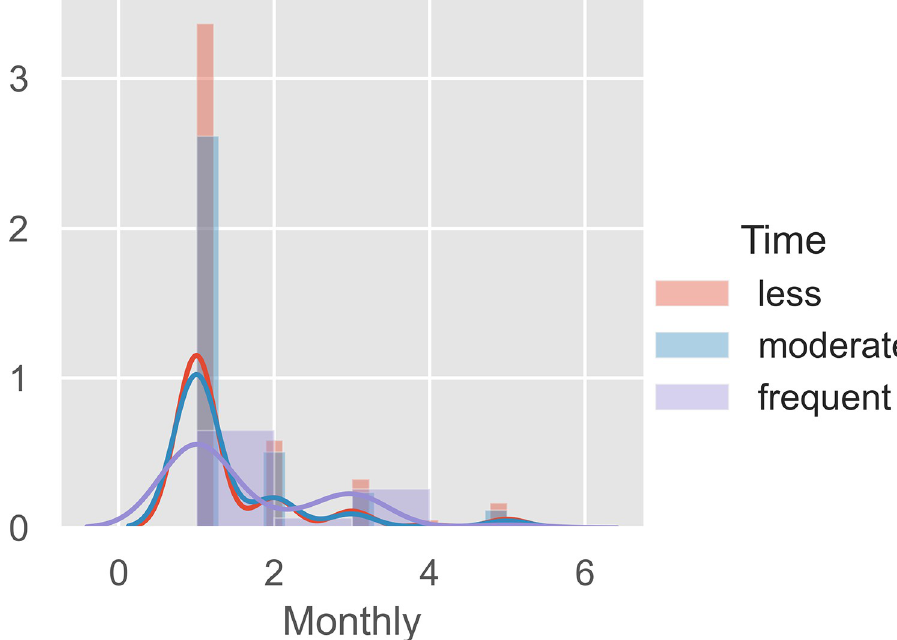
Fig 6. Cluster visualization through monthly allowance/salary.